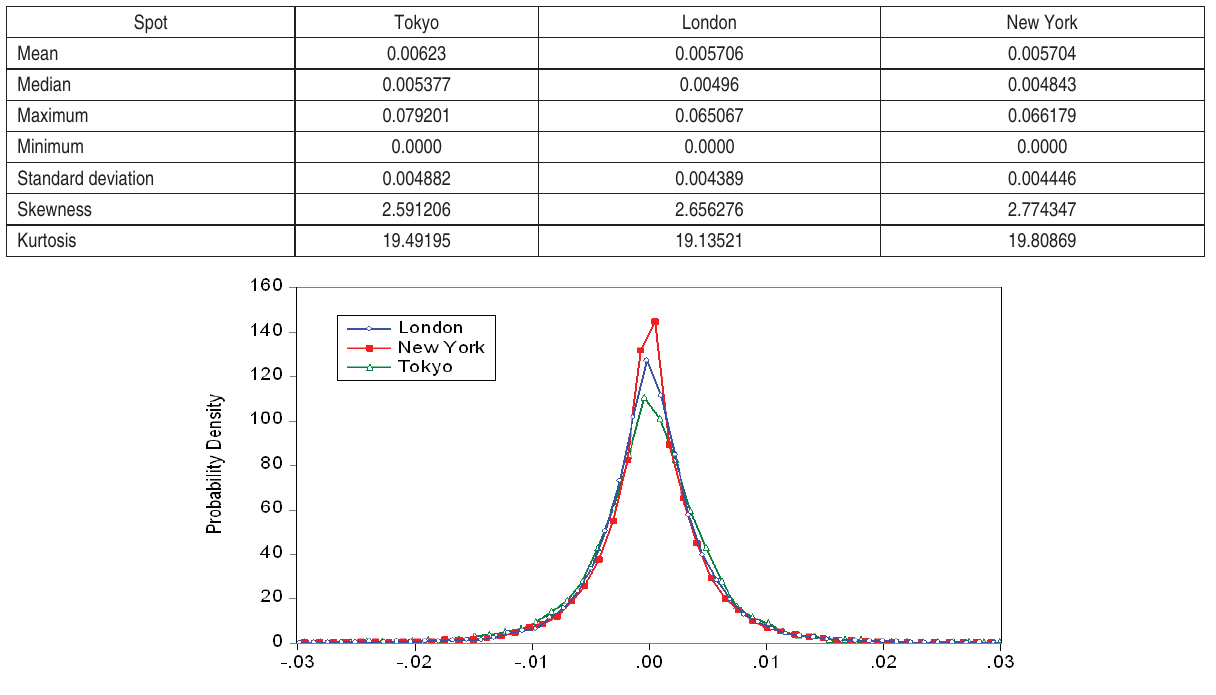
Fig. 2. Probability distributions of gold returns in